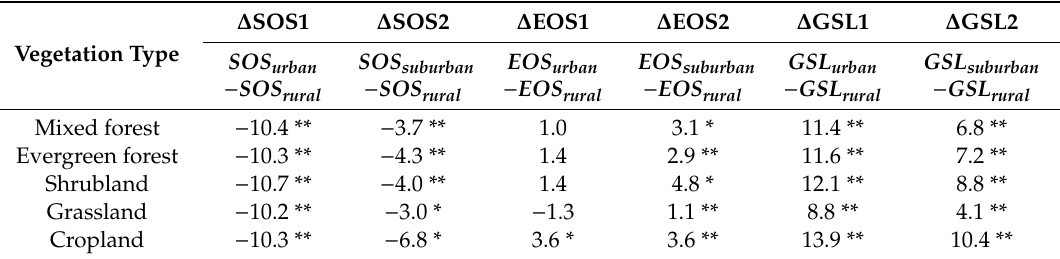
Table 2. Mean phenology di ff erences (2013–2018) of urban, suburban, and rural areas for di ff erent vegetation types in units of days. Variable definitions are as in Figure